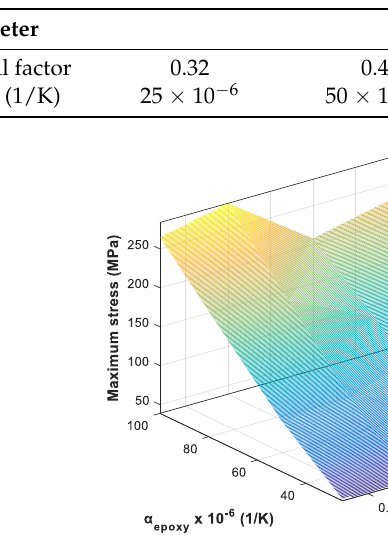
Table 3. Value of the parameters used in the parametric studies.